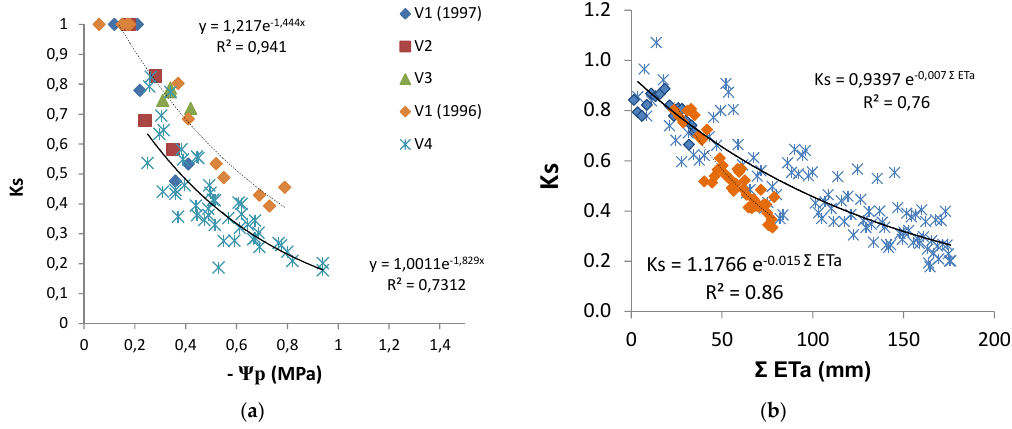
Figure 7. Relationship between Ks and ( a ) predawn leaf water potential ( Ψ p ) and ( b ) cumulated ET since the start of stress (Ks < 1) for vineyards (V1 to V4). Symbols are the same in both figures. The lines are shown with respect to the best fit for the extremes, i.e., to the locations with the highest (full line) and the lowest atmospheric demand (dashed line), in (a) for the days with Ψ p measurements and in (b) for the periods when Tr data allowed the calculation of Σ Tr. Adapted (a) and rebuilt (b) from Ferreira et al. [20].